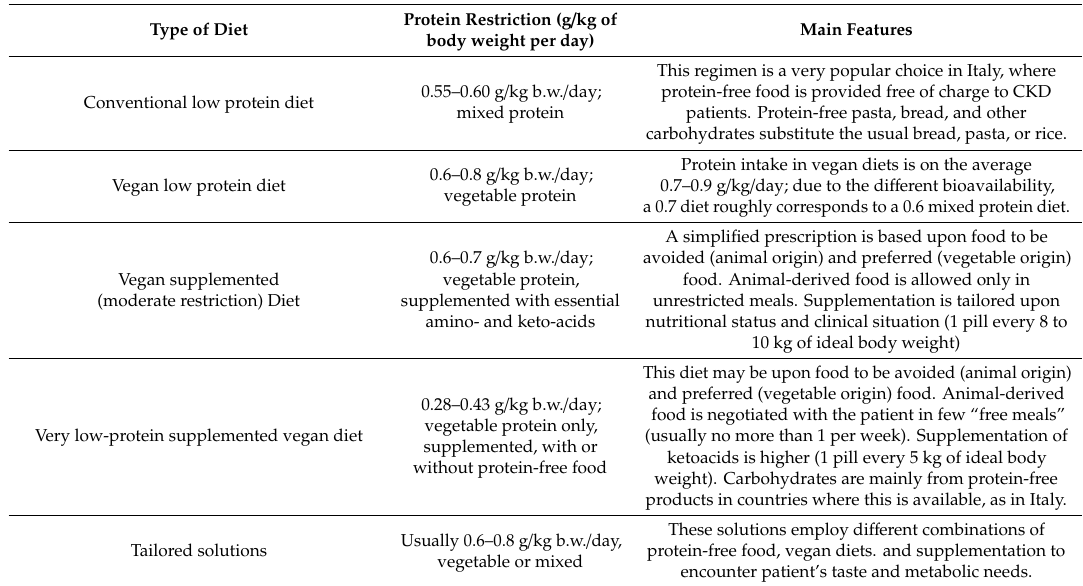
Table 1. Main types and dosages of low protein